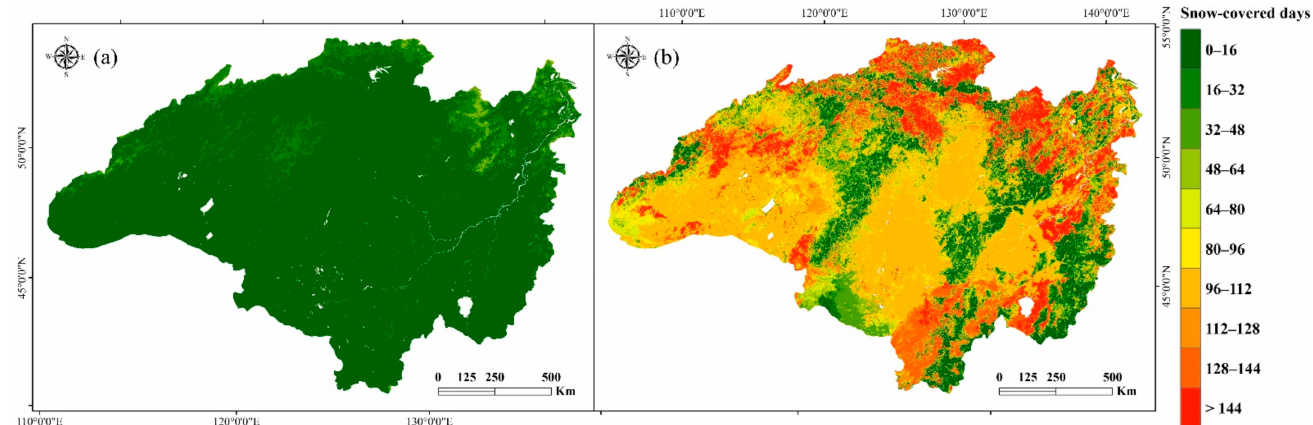
Figure 5. Snow-covered days in the growing season ( a ) and snowing season ( b ) in the basin. The white areas are water and other accessory land covers that are masked